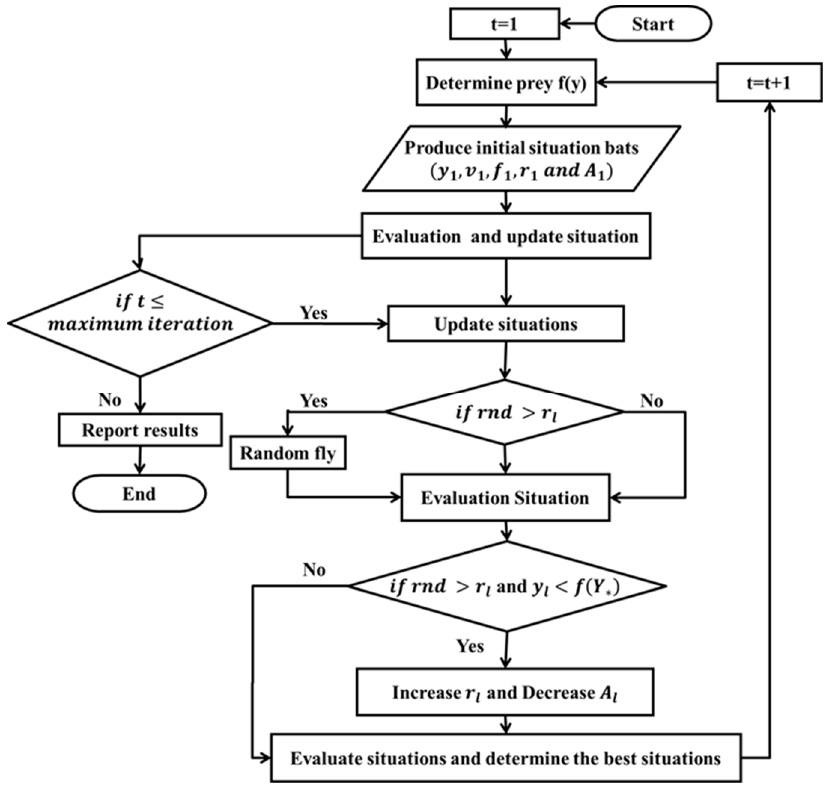
Figure 3. The structure of BA (rnd: random number).